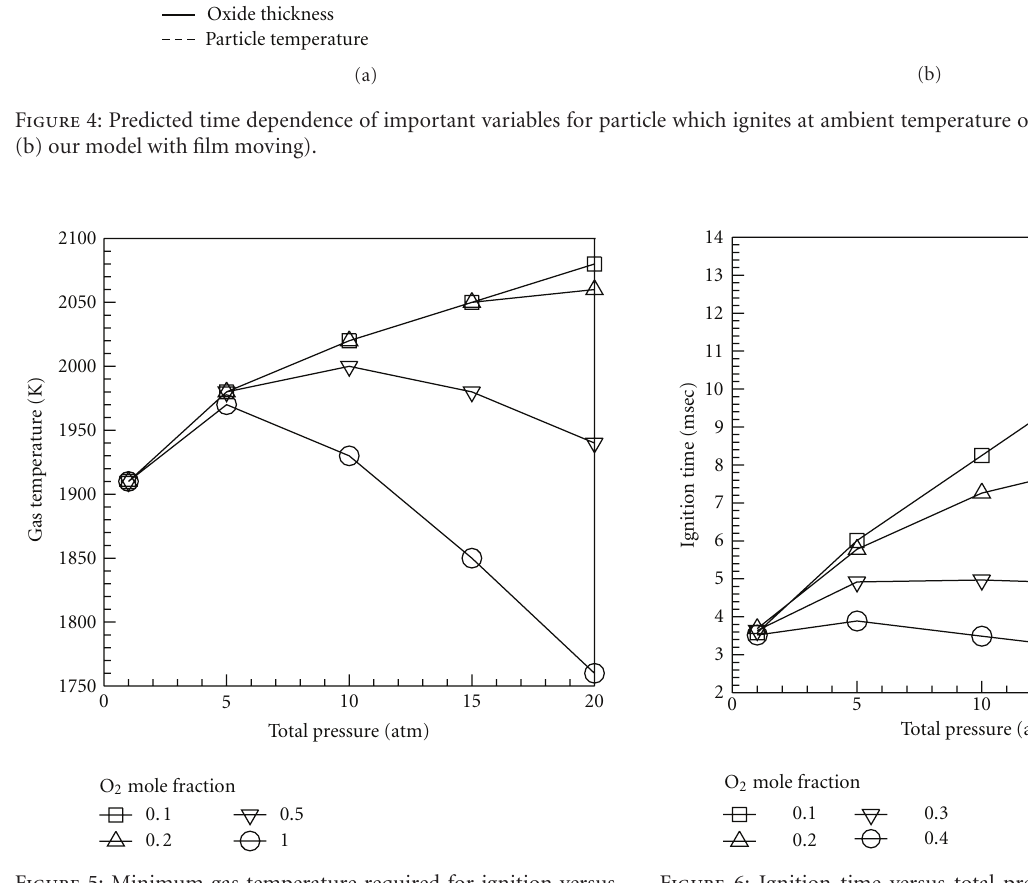
Figure 6: Ignition time versus total pressure for various oxygen mole